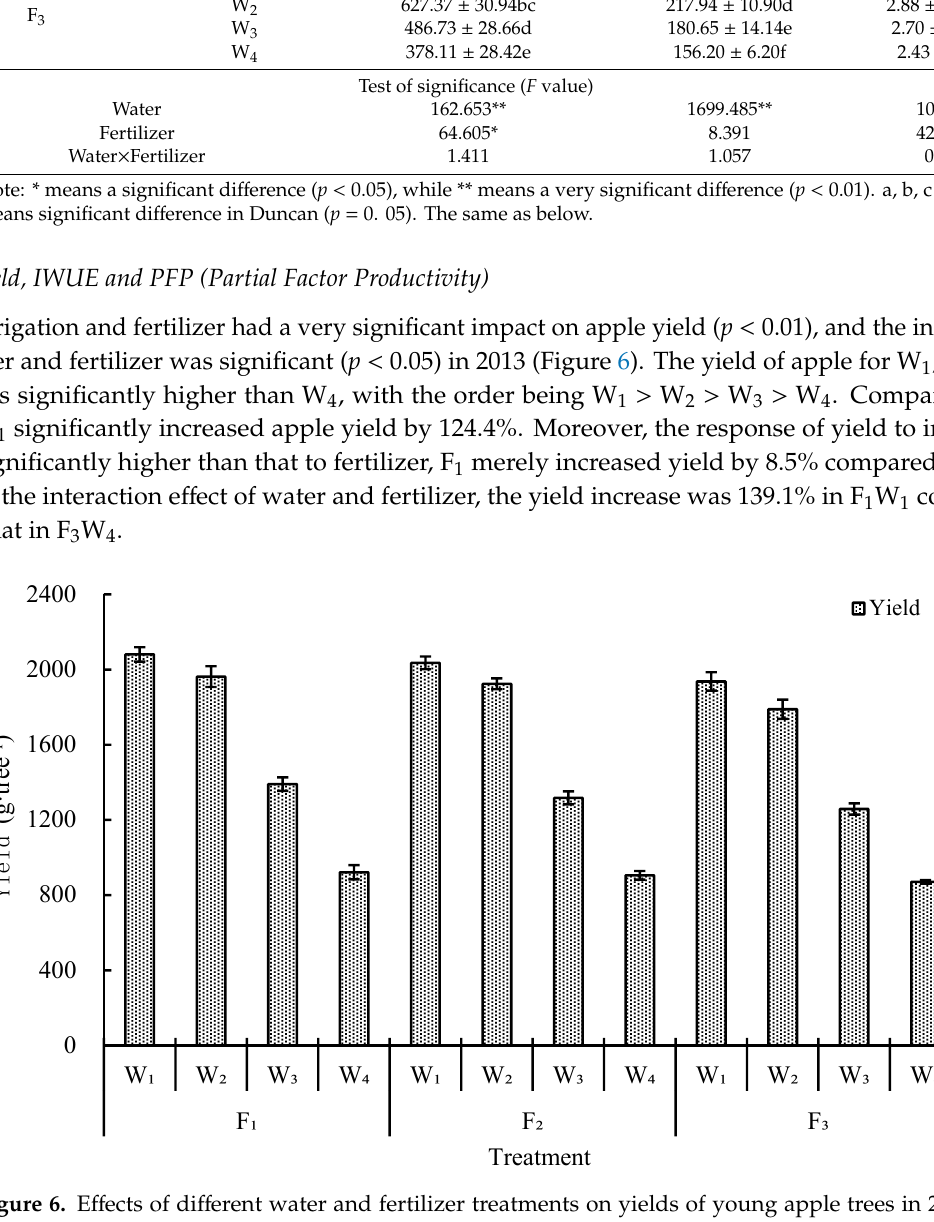
Figure 7. Effects of different water and fertilizer treatments on irrigation water use efficiency (IWUE) of young apple trees in 2013. The effect of irrigation on IWUE was very significant in 2013 ( p < 0.01), but it was not significant for fertilizer and the interaction of water and fertilizer ( p > 0.05).